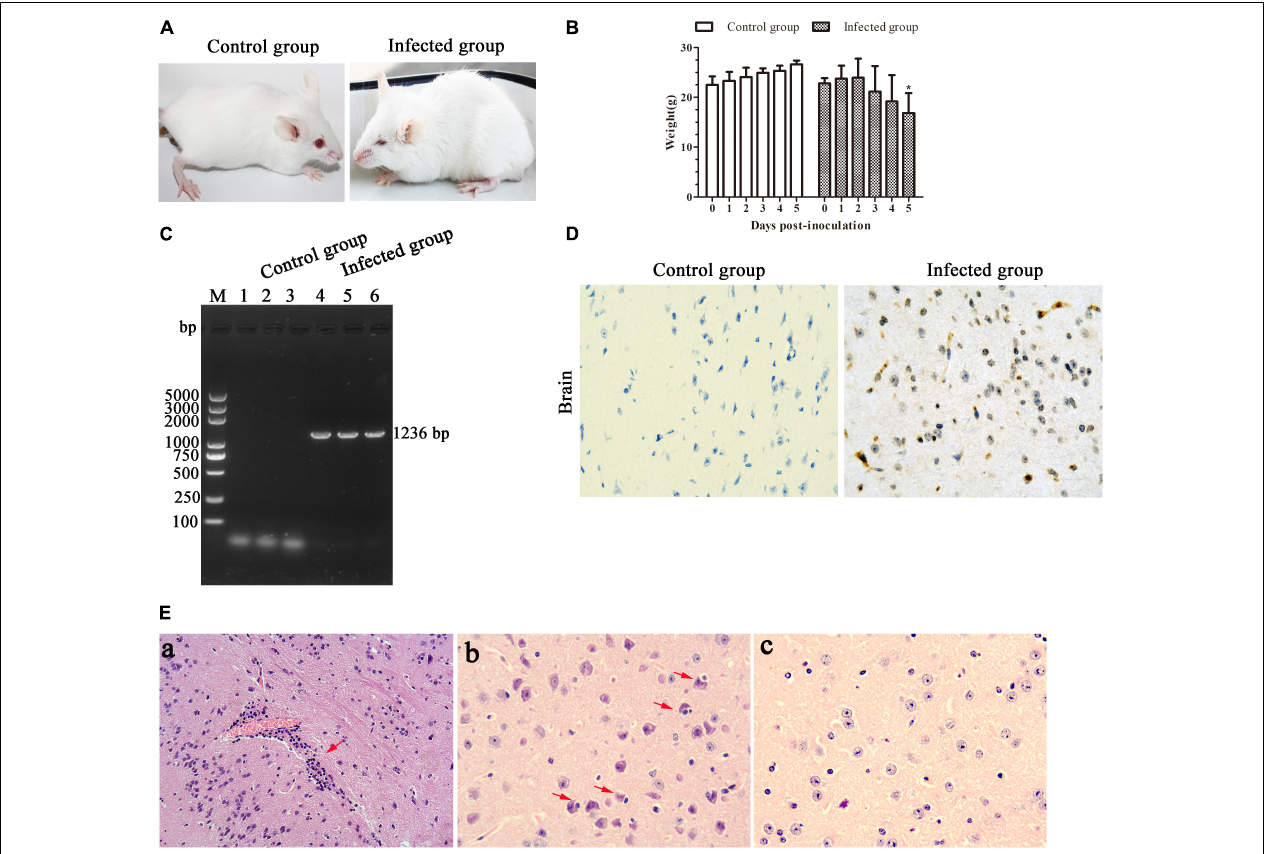
FIGURE 5 | Pathogenicity of the equine herpesvirus type 8 (EHV-8) isolate in mice. Six specific pathogen-free BALB/c mice were randomly divided into the infected and control groups. Clinical signs (A) and body weight (B) were monitored for 6 days. Differences between groups were assessed using t -test, and statistical significances were denoted by * p < 0.05 versus infected group mice at 0 day. The ORF70 gene was detected in brains from the control mice group and infected mice group by PCR (C) . Meanwhile, the brain tissues were fixed in 10% formalin solution for immunohistochemistry (IHC) for EHV-8 antigen detection using EHV-8-positive serum (D) (IHC × 400) and histopathological analysis (E) . (a) Perivascular cuffing (HE, × 200); (b) neuronophagia of glial cells (HE, × 400); (c) mice brain tissue in the control group (IHC, ×